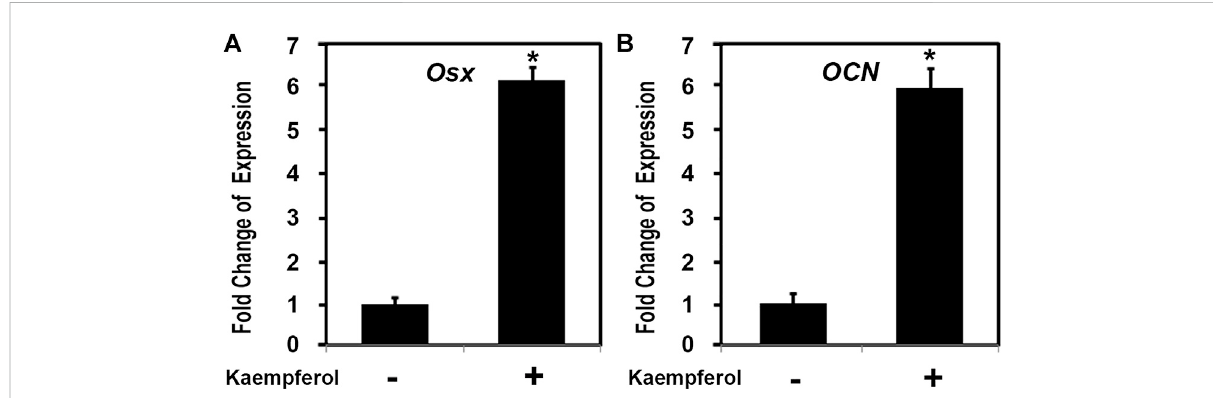
FIGURE 10 Kaempferol induced the expression of osteoblast genes. C2C12 cells were treated with 1,000 ng/ml kaempferol for 24 h. Total RNA was isolated and measured by real time RT-PCR. The RNA level from the control group was normalized to a value of 1. Values were presented as the mean±S.D.*:Astarindicatesstatistical signi fi cancecomparedtocontrolgroupwith p < 0.05. (A) EffectofkaempferolonOSXexpression; (B) Effect of kaempferol on OCN expression.